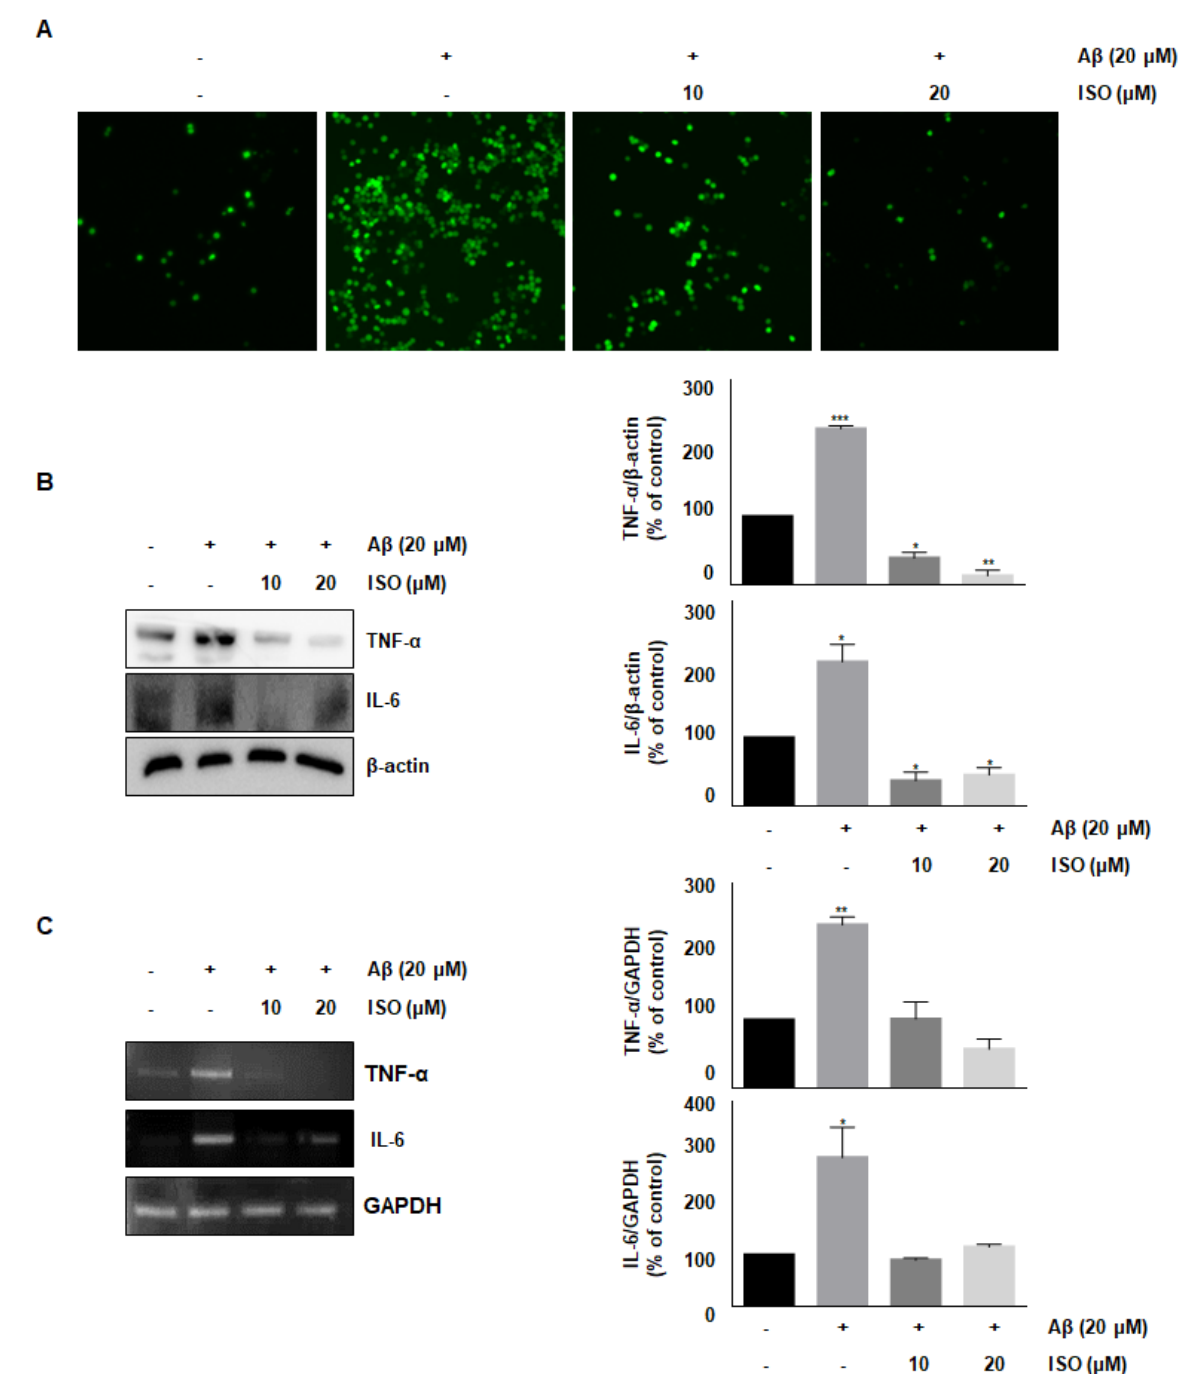
Figure 2. ISO inhibits A β 25–35 -induced ROS generation and expression of inflammatory cytokines in BV2 cells. BV2 cells were pretreated with different concentrations of ISO as indicated 1 h before the addition of A β 25–35. ( A ) Intracellular ROS levels were measured by the DCF-DA. ( B ) The protein levels of TNF- α and IL-6 were determined by Western blotting. ( C ) The mRNA levels of TNF- α and IL-6 were determined by the RT-PCR. β -actin and GAPDH were used as loading controls. The experiments were repeated more than three times and similar results were obtained. Data indicate mean ± SEM of three independent experiments. * p < 0.05, ** p < 0.01, *** p < 0.001 versus